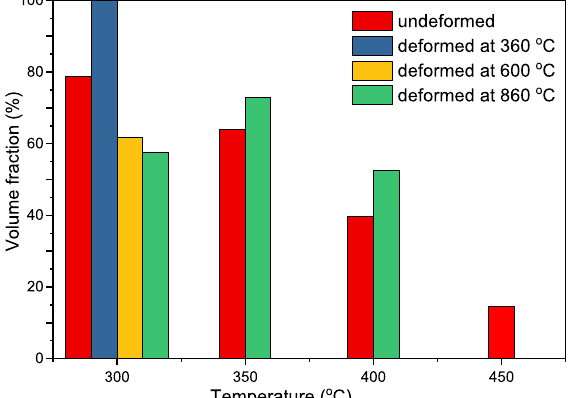
Figure 8. Volume fraction of transformed bainite as a function of isothermal temperature in different deformation